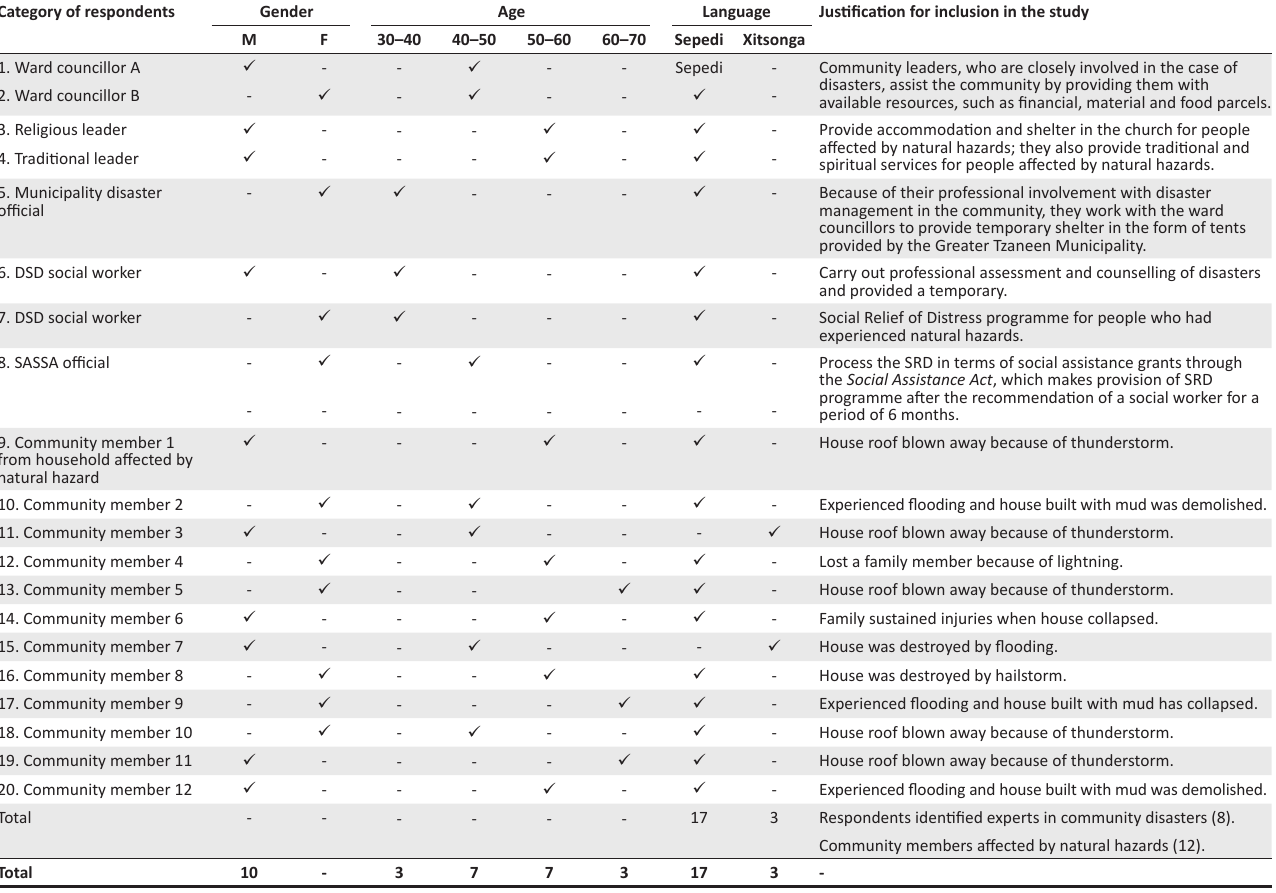
TABLE 1: The demographic information of the respondents identified as experts in community disasters ( N = 20). Category of